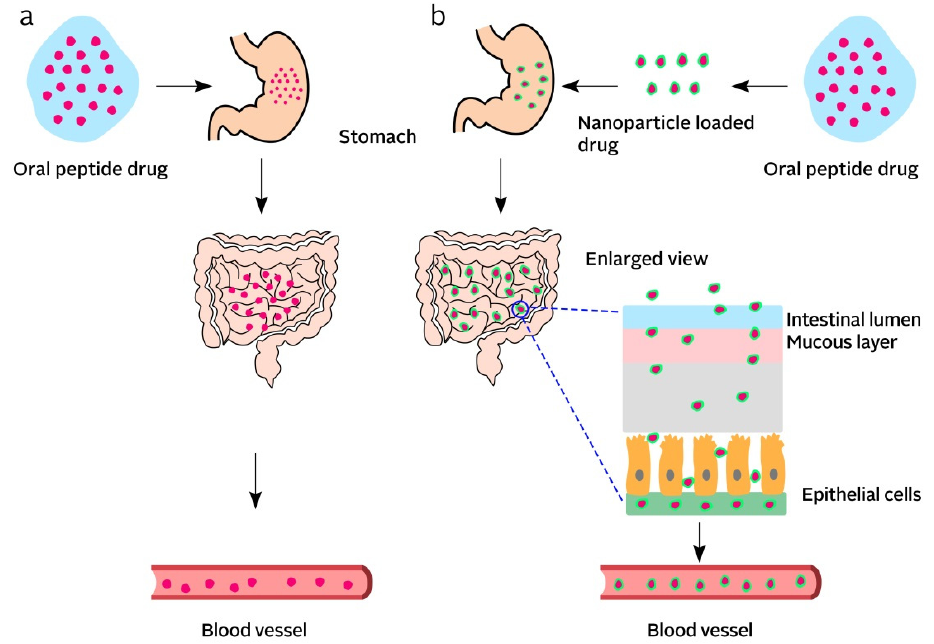
Figure 3. Oral administration of pH sensitive peptide drug: ( a ) an orally administered peptide drug is degraded particularly in the stomach due to proteolytic enzymes, which results in poor drug availability, ( b ) nanoparticles protect drugs and prevent them from enzymatic degradation. The drug distribution is more efficient. Adapted with permission from [89], Elsevier, 2019.